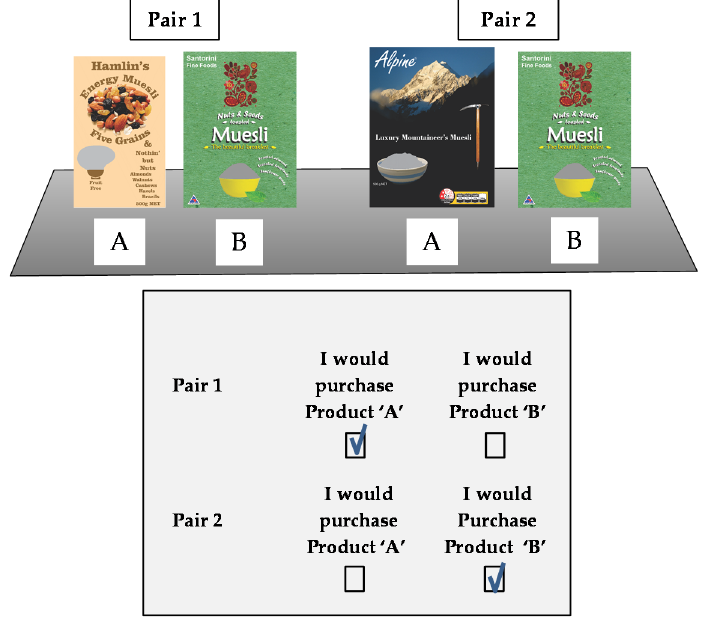
Figure 3. Choice task as presented to a consumer in Group 2 of the experimental sample.